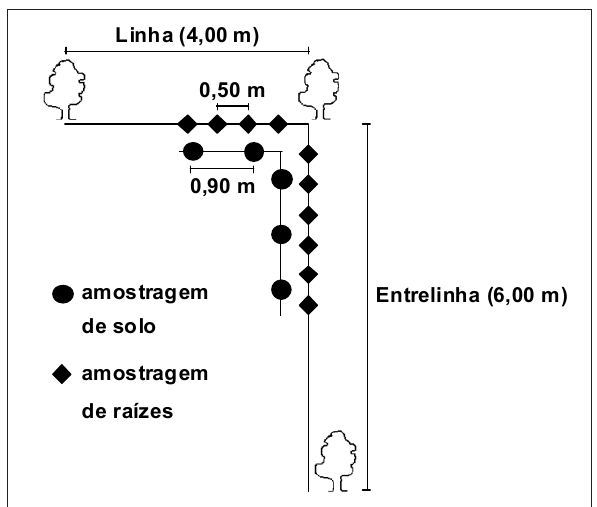
Figura 1. Esquema de amostragem de solo e de raízes em pomares de citros estabelecidos em Latossolo Amarelo e Argissolo Acinzentado de Tabuleiros Costeiros do Estado da